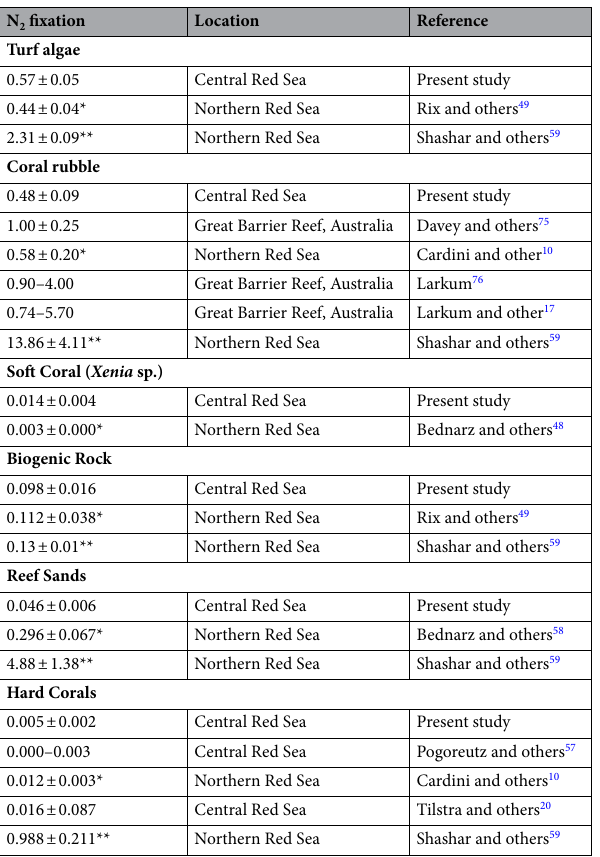
Table 2. N 2 fixation rates (nmol N 2 cm −2 h −1 ) of investigated benthic categories in comparison with values reported from other coral reef areas worldwide acquired via acetylene-based assays. All N 2 fixation rates were converted with a conservative conversion factor of 4:1 (C 2 H 4 :N 2 ) according to Mulholland et al. 157 . Values are presented in mean ± SE. *Winter season; **Summer